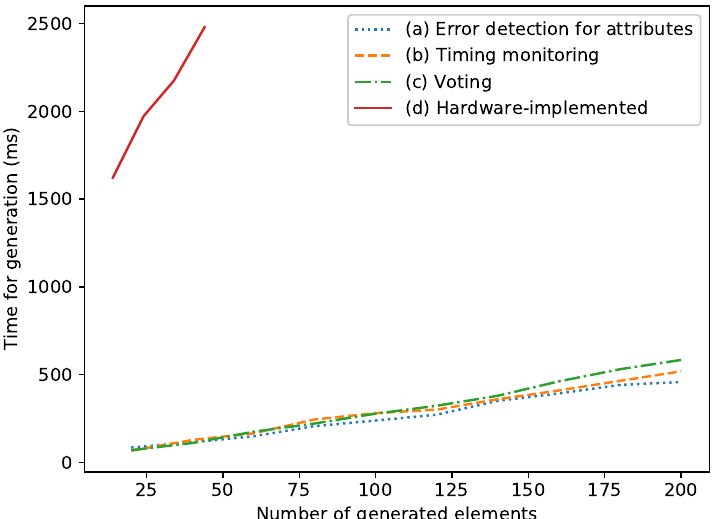
Figure 15. Runtime for generating software- and hardware-implemented safety mechanisms. Note that the measurements for hardware-implemented safety mechanisms have only been conducted for a smaller number of generated elements than software-implemented safety mechanisms, due to the necessity of a corresponding number of physical hardware interfaces being available on the studied